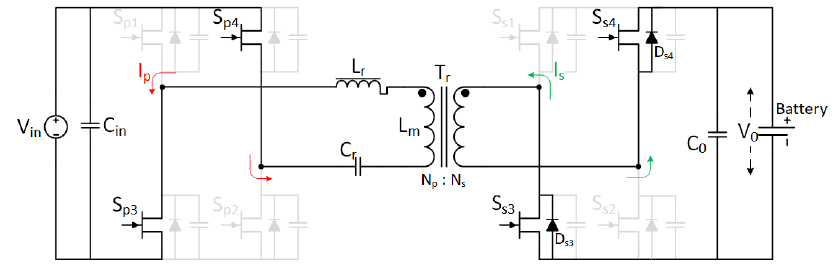
Figure A5. LLC resonant converter topology interval-5.